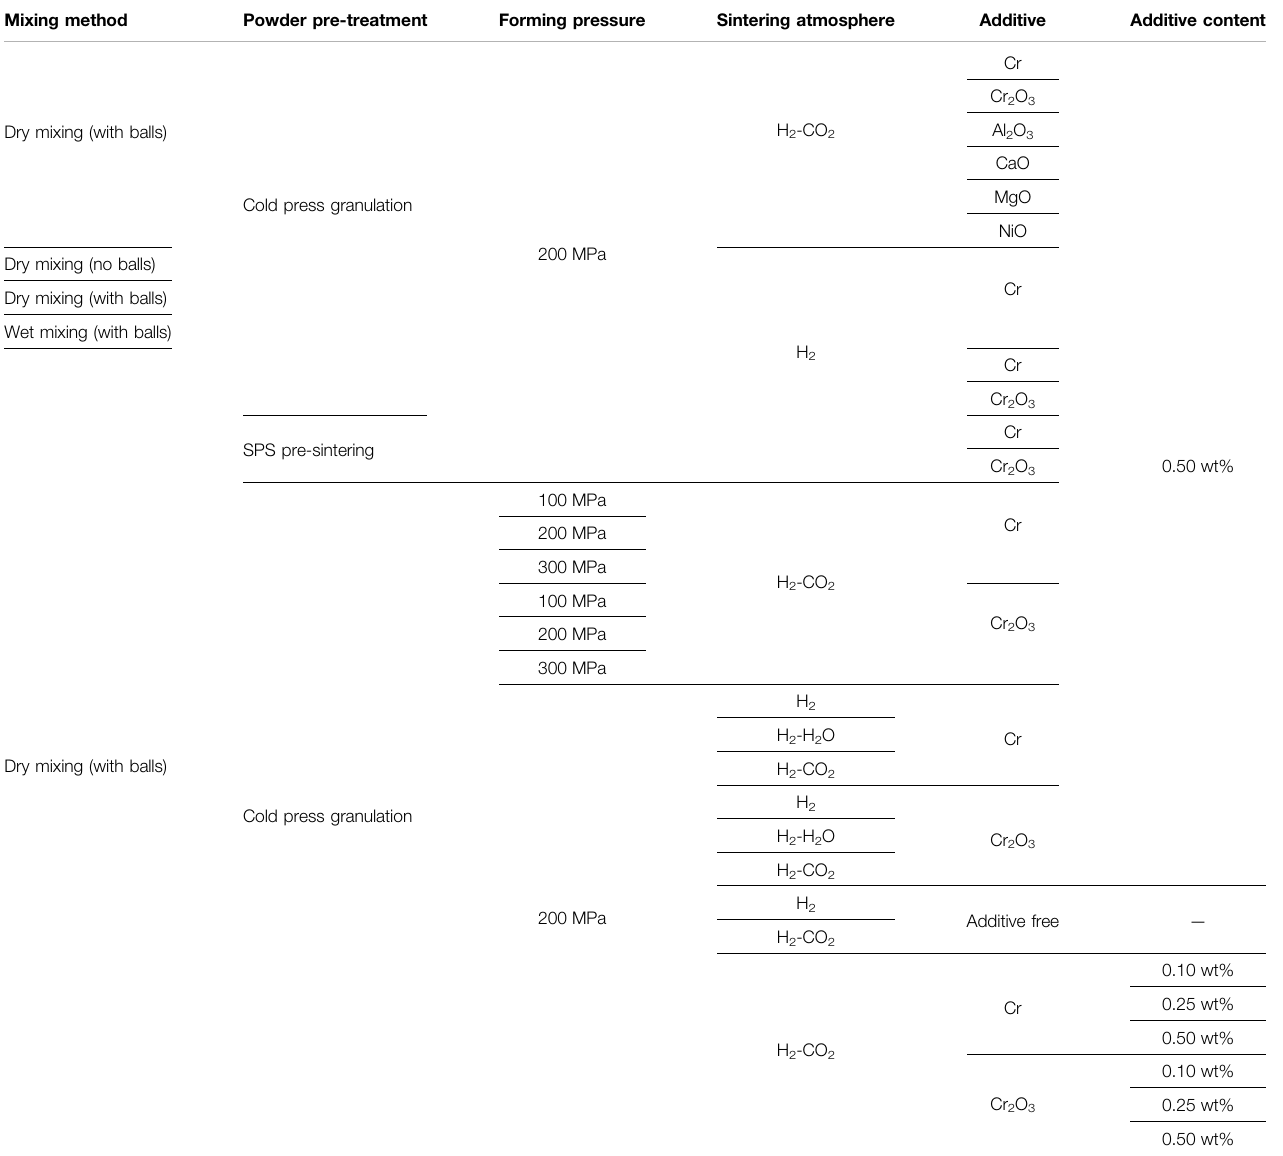
TABLE 2 | Process conditions and parameters used in the experiment. Mixing method Powder pre-treatment Forming pressure Additive